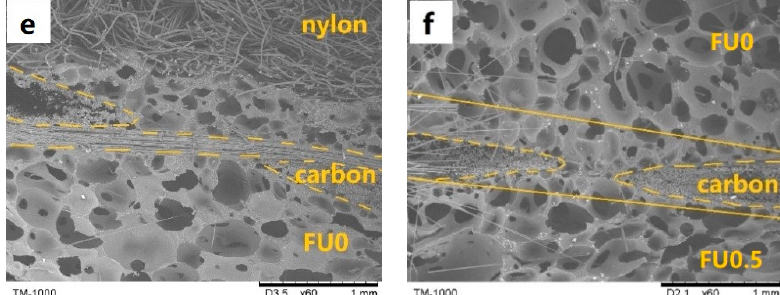
Figure 6. SEM images of fabric and cross section of MFRCs. ( a ) Cross section of interface of upper and lower layer of N-FU0-0.5, ( b , c ) cross section of spacing fabric structure and foam, ( d ) cross section of nylon and foam, ( e ) cross section of nylon and carbon fabric of N/C-FU0-0.5/S, and ( f ) cross section of carbon fabric and foam of N-FU0-C/0.5/S.